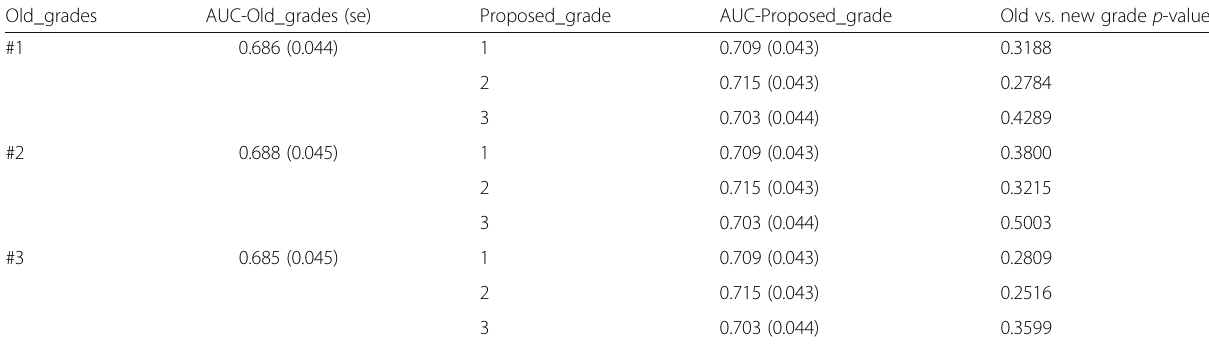
Table 5 Comparison of AUC for predicting PUC-Ta tumor recurrence between previous grading systems and our proposed grading